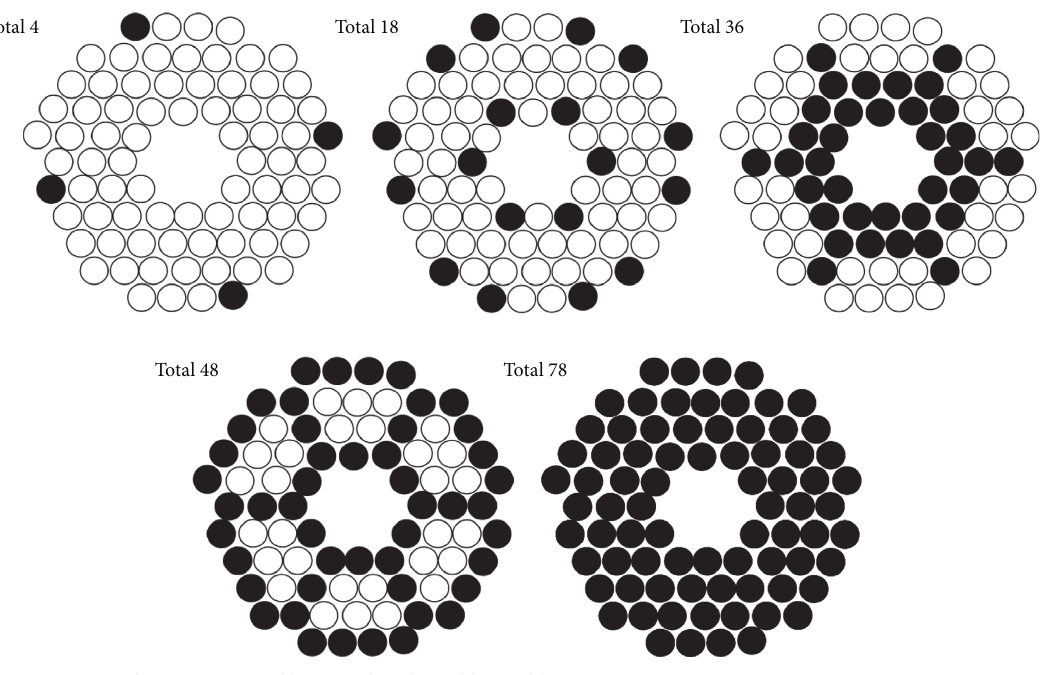
Figure 10: Number and location of empty quartz molds positioned in mold assembly before casting.